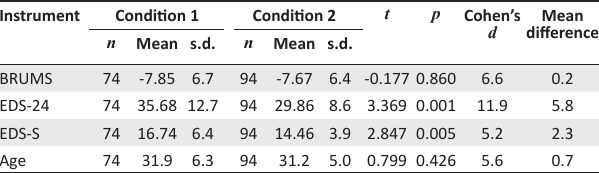
TABLE 5: The outcome of the t -tests for independent samples for Brunel Mood Scale and Emotional Dysregulation Scale. Instrument Condition 1 Condition 2